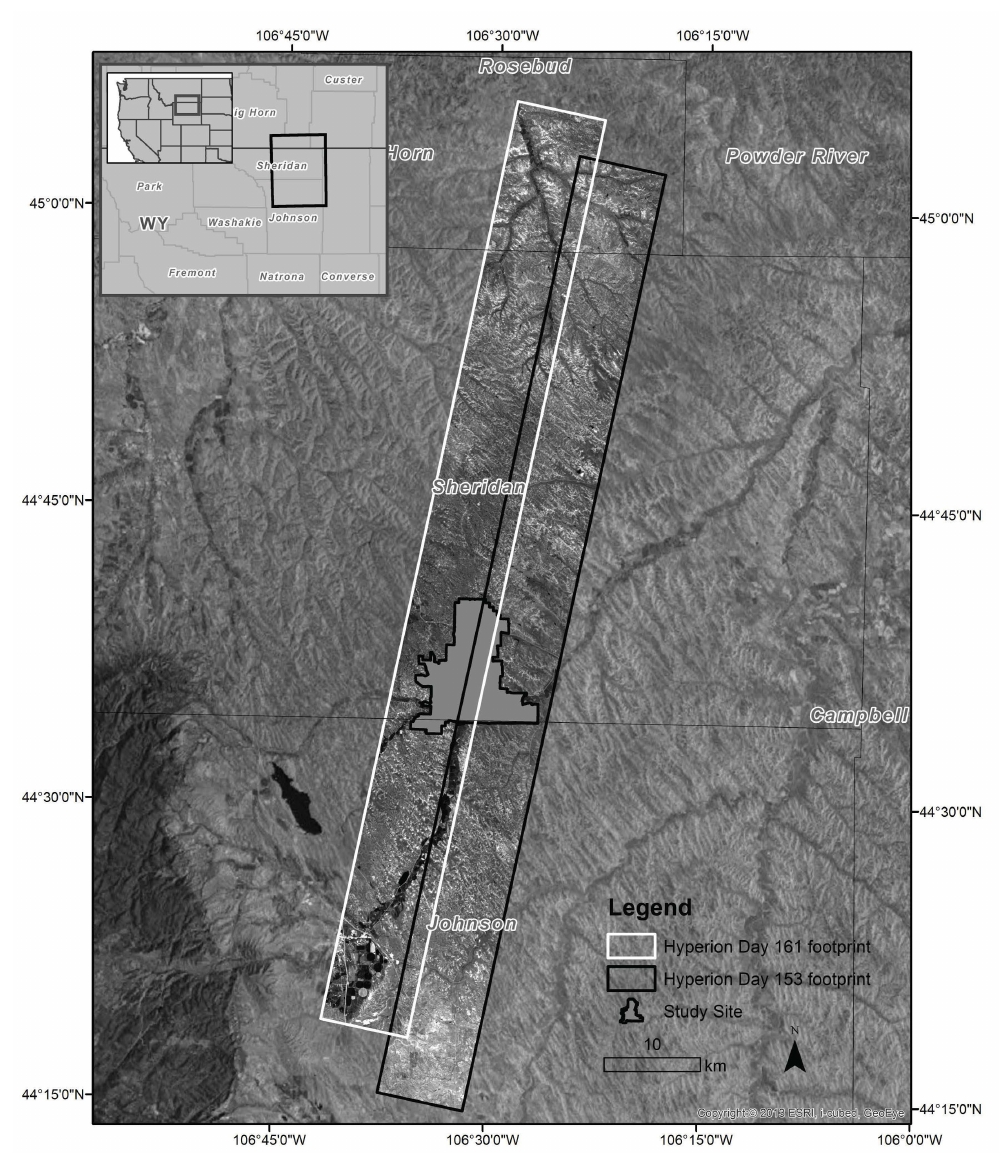
Figure 3. A map of the study site showing the Hyperion flight lines for Days 153 and 161 of